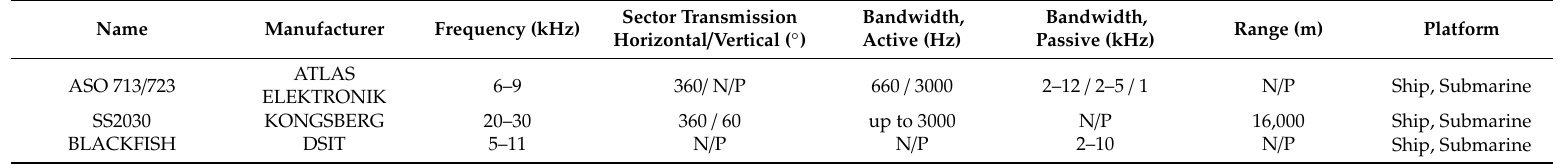
Table 14. Acoustic sensor: passive / active sonars—hull-mounted sonar (HMS).